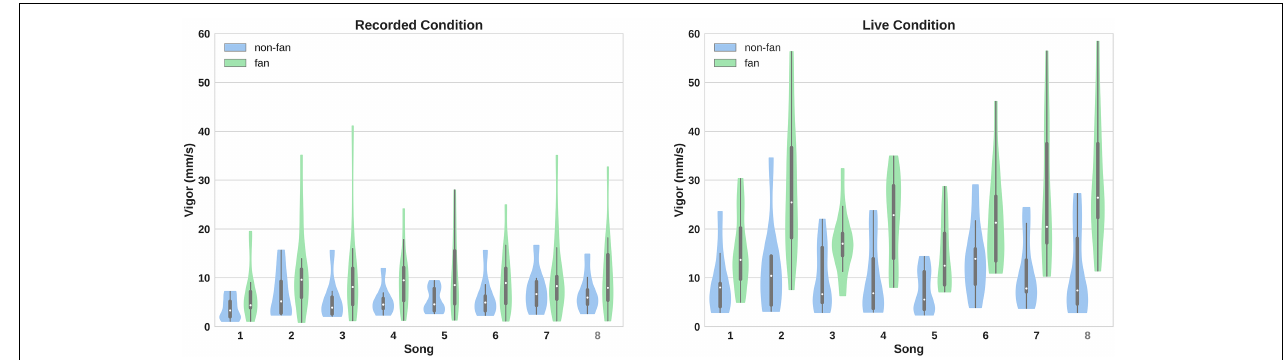
FIGURE 1 | Vigour of head movements across songs. The distance travelled within a song was divided by the total length of the song, giving a value in millimetres per second. Fans moved with greater vigour than Neutral-listeners for every song and those in the Live Concert condition moved with greater vigour than those in the Album-playback Concert condition for every song. Vigour varied among songs, and was qualified depending on Concert-status (Live, Album-playback). The songs were: (1) “Just to Know I Can”; (2) “How Long”; (3) “Fool”; (4) “Elouise”; (5) “Frozen Pond”; (6) “Feel”; (7) “Secrets”; and (8) reinterpretation of “Blown Wide Open.” The violin plots show the same parameters as a standard box plot (range, interquartile range and median) as well as a kernel density plot that estimates the continuous distribution of the data.